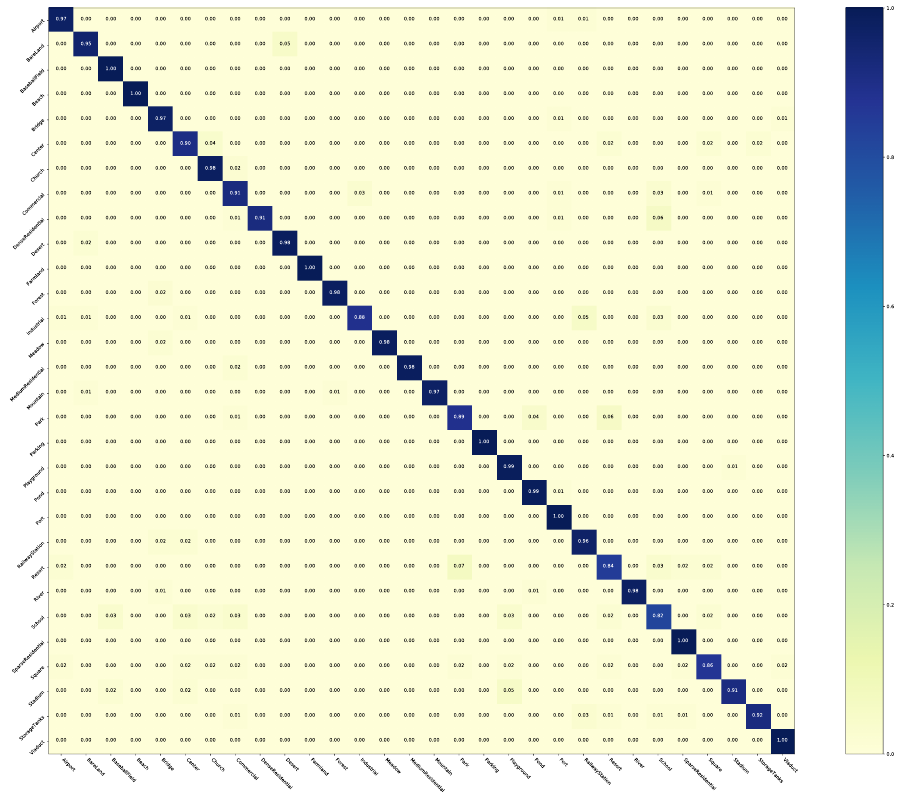
Figure 12. The confusion matrix of NLD for the AID dataset with asymmetric noise of D c : D n = 2 : 8.